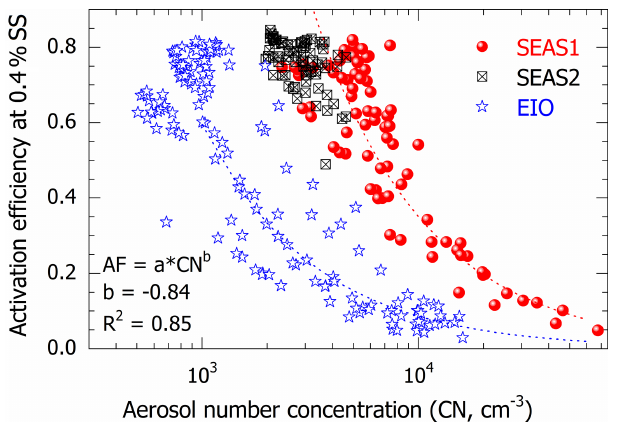
Figure 5. Association of activation efficiency at 0.4% supersatu- ration (SS) with CN number concentration during SEAS1, SEAS2 and EIO of ICARB-2018. Dotted lines indicate regression fit to the